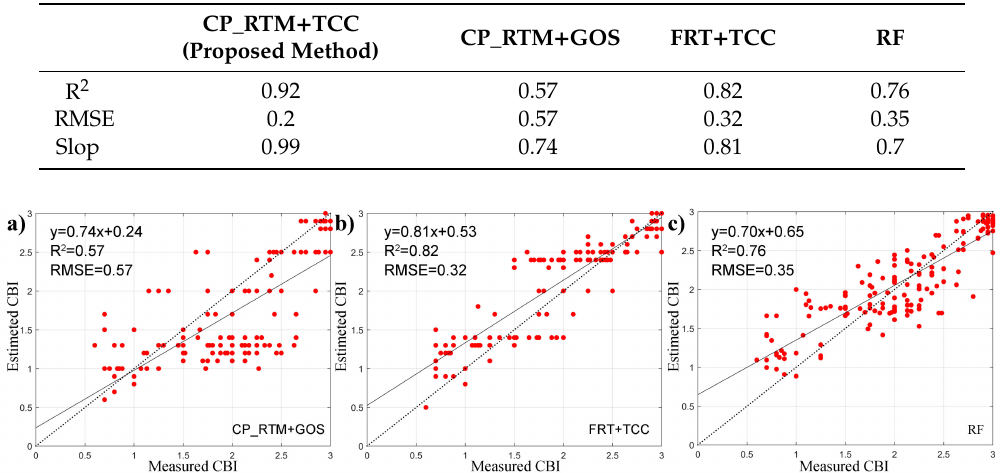
Figure 7. Field measured versus estimated burn severity (expressed as CBI) based on ( a ) CP_RTM + GOS, ( b ) FRT + TCC, and ( c ) RF method for two study sites. The dotted line and solid line represent the 1:1 line and fitting line,